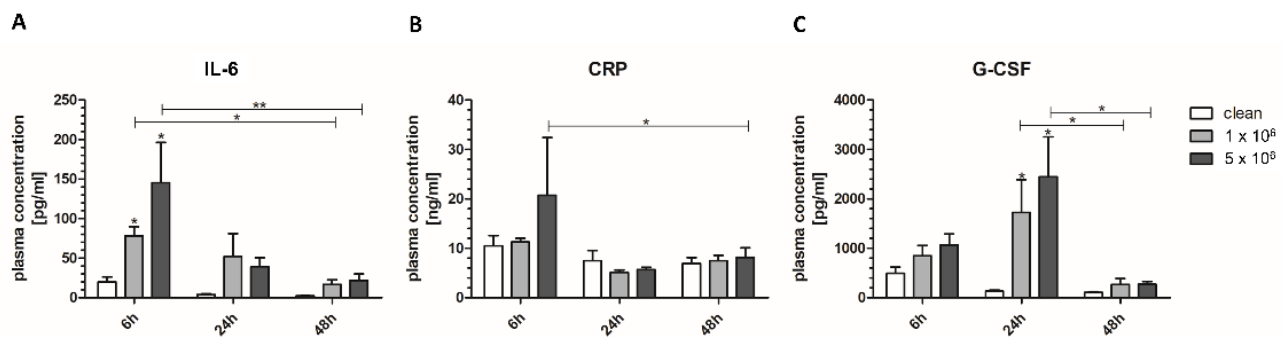
Figure 2. Blood plasma levels of the cytokines ( A ) Interleukin-6 (IL-6), ( B ) C-reactive protein (CRP) and ( C ) granulocyte colony stimulating factor (G-CSF) measured via luminex assay. Statistical analyses above the bars are in reference to the clean control sample at the same time point.*: p < 0.05, **: p < 0.01.